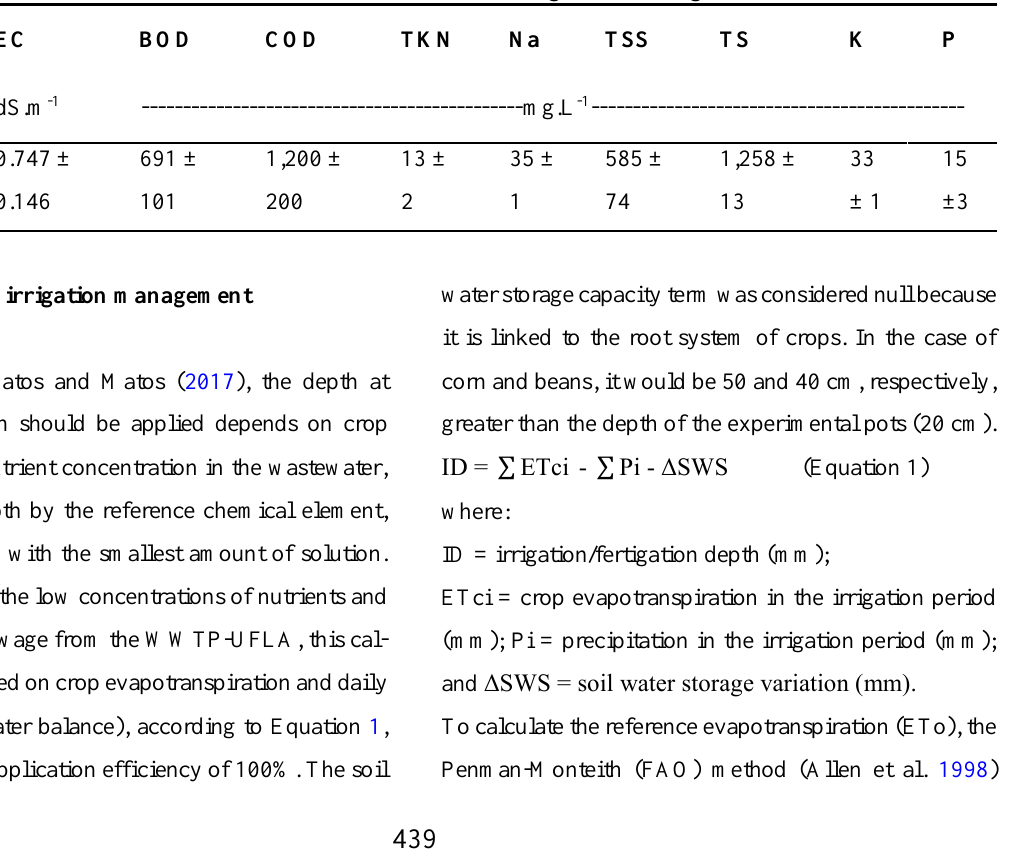
Table 1 Physical and chemical characterization of WWTP-UFLA sewage before